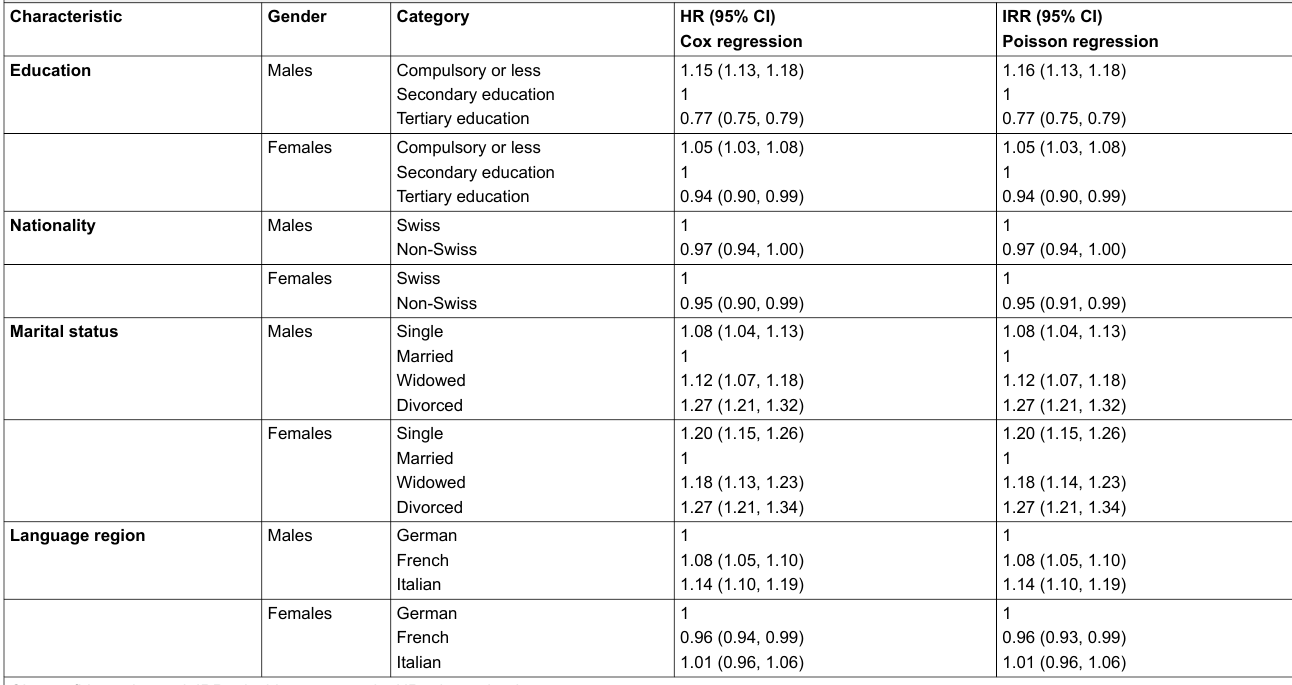
Supplementary table 2 Comparison of all-cancer mortality risk from 1991 through 2008 in older Swiss adults ≥65 years old using Cox proportional hazards and Poisson regression models.